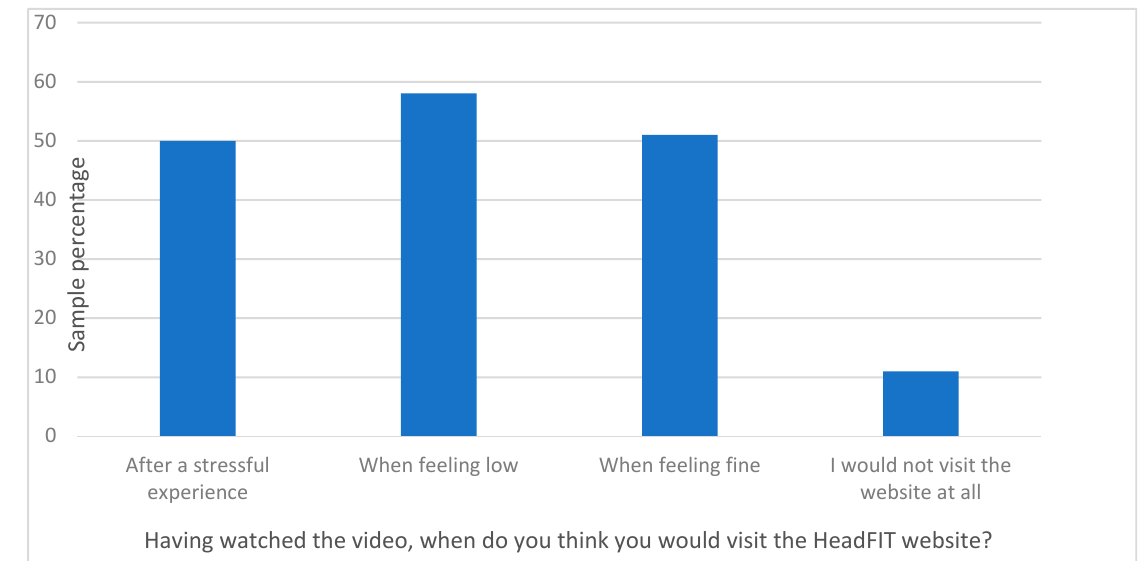
Figure 3. When beneficiaries would visit the HeadFIT website. Note: Beneficiaries were able to select more than one re- sponse.